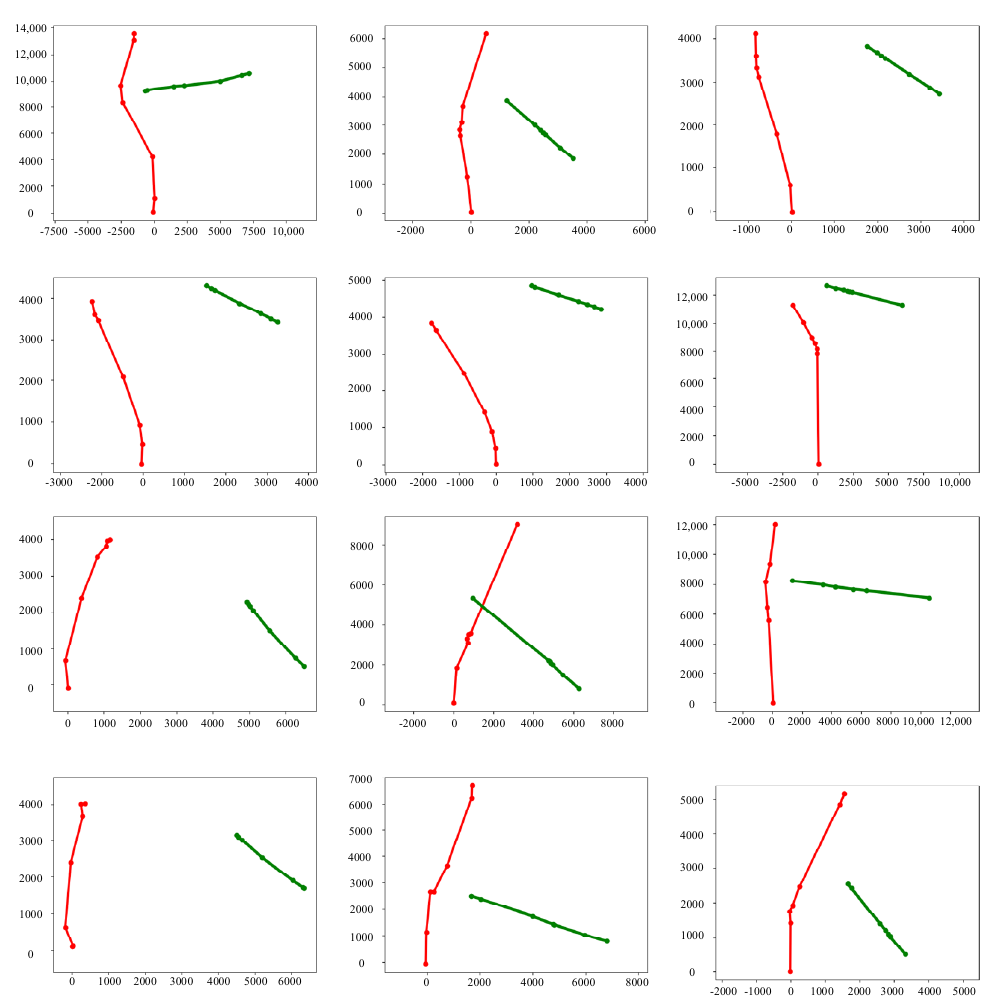
Figure 20. Collision-avoidance decision-making using the encoder–decoder structure.